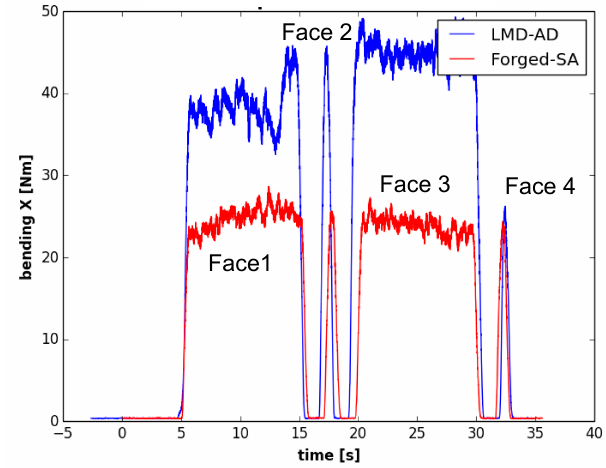
Figure 13. Bending moment evolution over time in the first set of experiments (second pass).